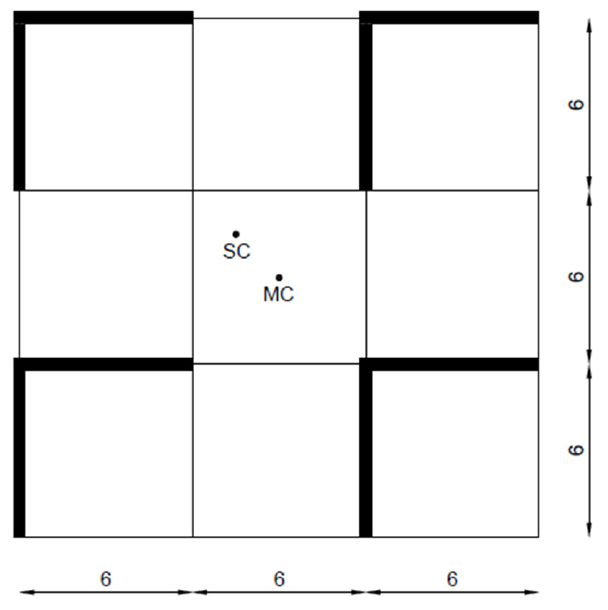
Figure 21. Plan of the multi-storey building with the non-symmetrical X-CBF configuration (case studies 7 and 8).